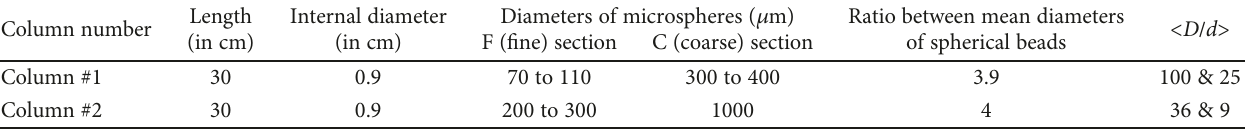
Table 3: Characteristics of the two-layer media columns.